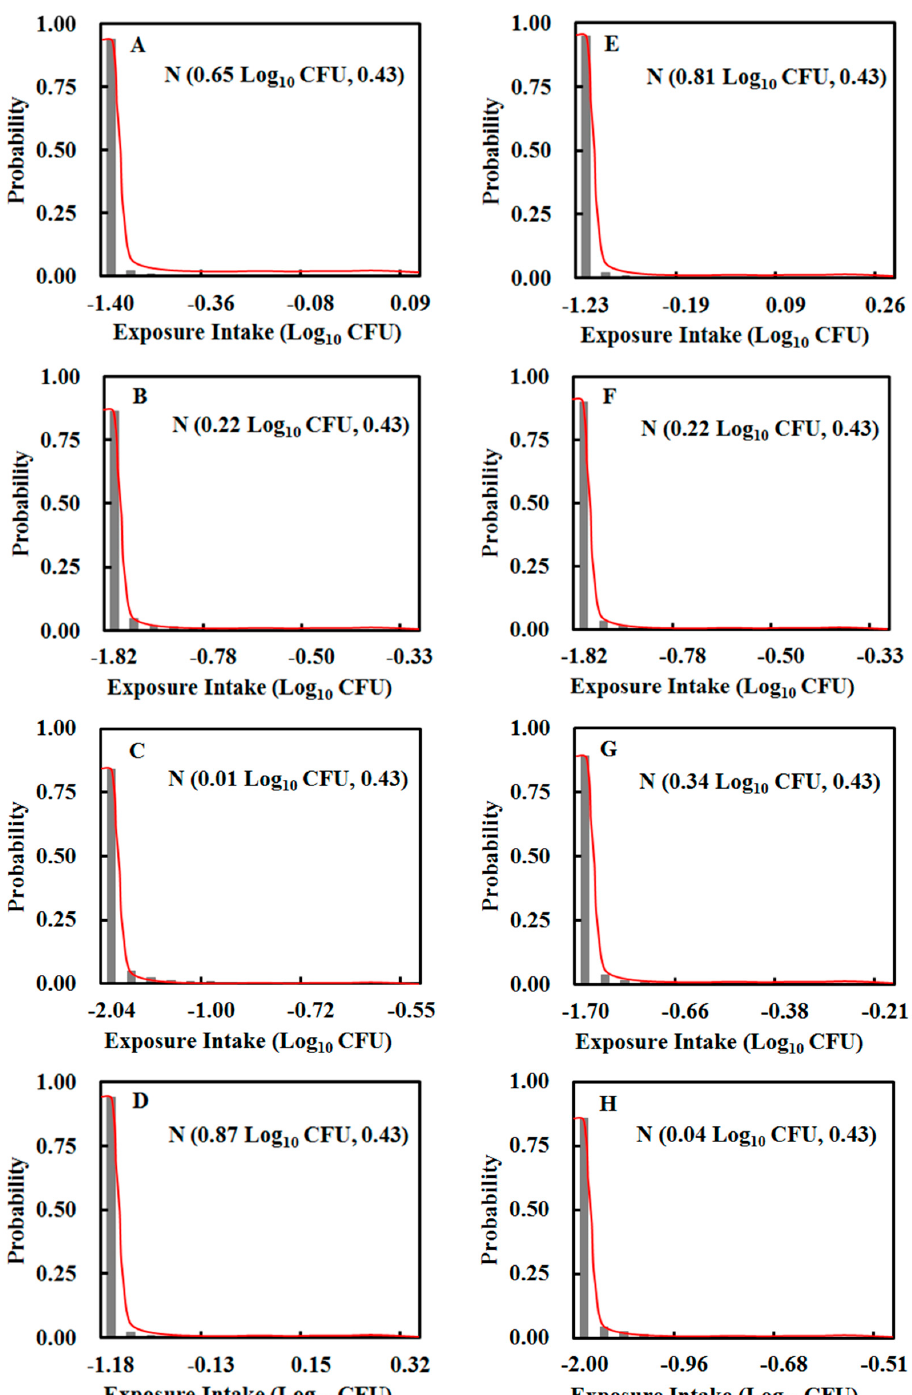
Figure A1. The probability distribution of ingesting E. coli O157:H7 among the Taiwanese population for each sex and age group from consuming rare beef imported from the USA. ( A ) Males and females aged 4-12 years, ( B ) males aged 13-18 years, ( C ) females aged 13-18 years, ( D ) males aged 19-65 years, ( E ) females aged 19-65 years, ( F ) males aged >65 years, ( G ) females aged >65 years, and ( H ) females aged 19-49 years (of childbearing age).